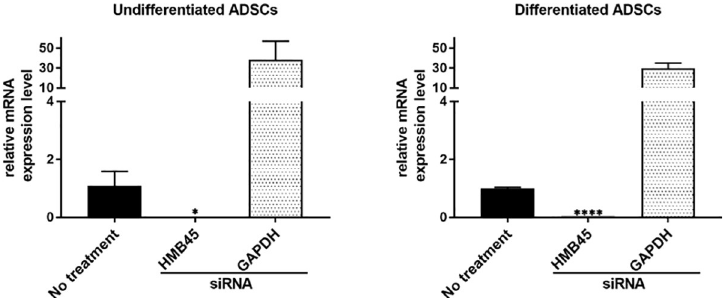
Fig 3. siRNA-mediated downregulation of HMB45 in differentiated ADSCs. siRNA resulted in the downregulation of HMB45 in undifferentiated ADSCs and differentiated ADSCs.